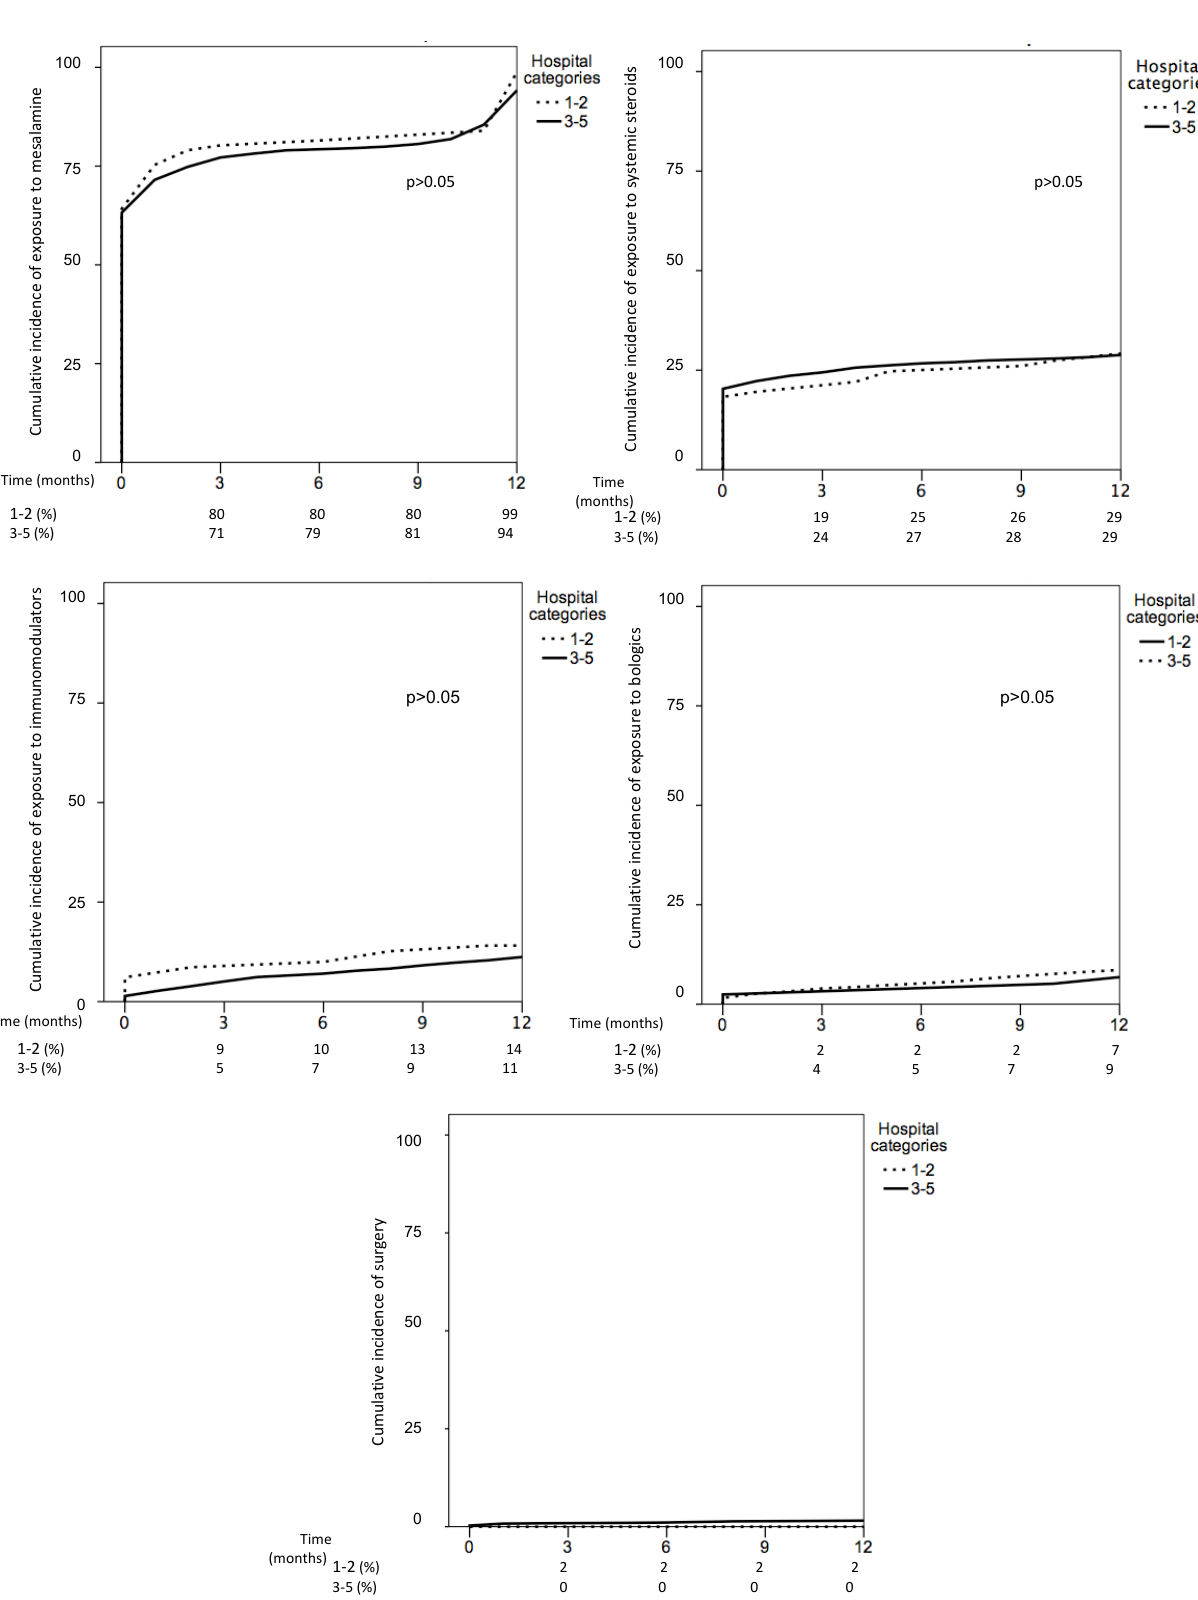
Figure 4. Cumulative incidence of treatments in ulcerative colitis based on hospital categories: low resources ( 1 and 2 ) vs. higher resources ( 3 – 5